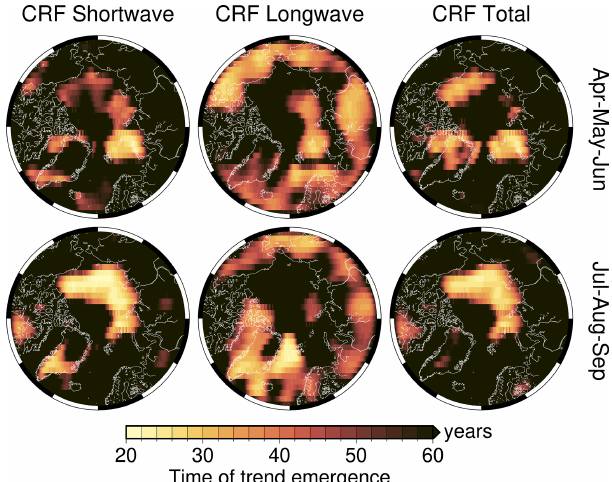
Figure D1. Time of emergence (ToE) of the trend to become sta- tistically significant at 95%. The first year of trend emergence for each Arctic region is listed in Tables 2 and